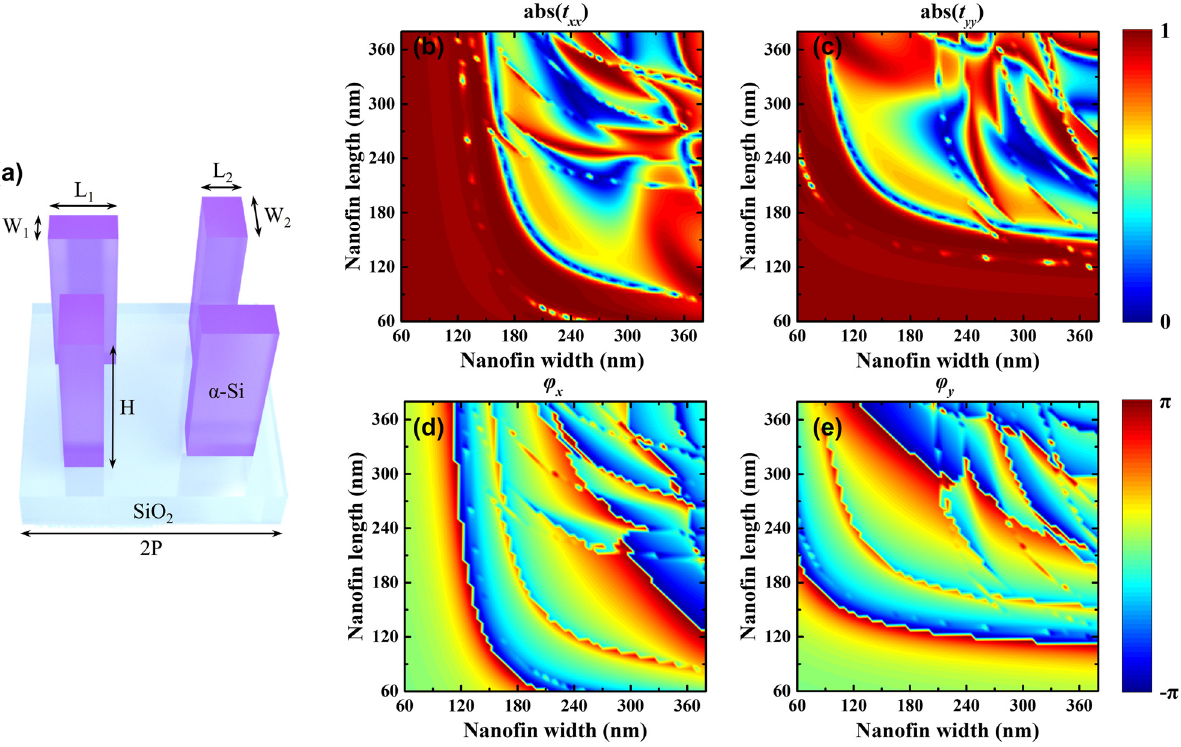
Figure 2: Simulated results of single nanofin. (a) The illustration of the supercell to constitute the demonstrated metasurface. Each supercell consists of 2 × 2 𝛼 -Si nanofins that set on a quartz substrate. The height of naonfin is 600 nm. And the period of the supercell is 900 nm. (b)–(e) Simulated amplitude (abs( t ), abs( t )) and phase ( 𝜑 , 𝜑 ) of the transmission coefficients t xx yy x y the range of 60 nm–380 nm with an interval of 5